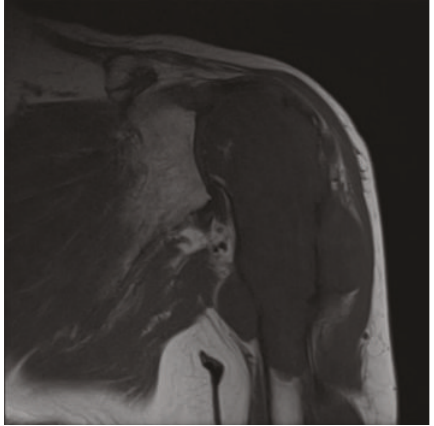
Figure 5: 60-year-old female with swelling in upper arm. MRI was done on 1.5T Siemen’s machine. Coronal MRI, STIR T2WI showing a well-defined lobulated hyperintense lesion with fibrous septae in the medulla and cortex. Involvement of the soft tissue on medial and lateral aspect (arrow).